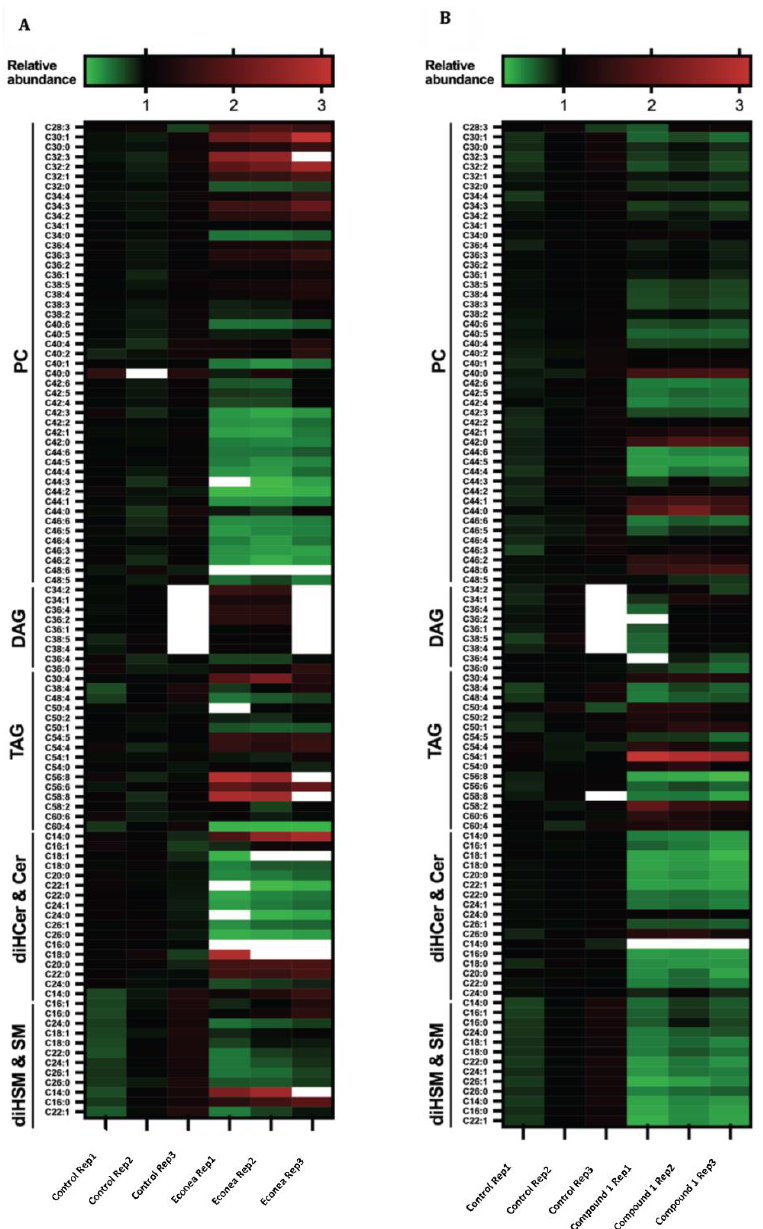
Figure 3. Heat map of differentially expressed lipids in several replicates of control, 10 µM of the Econea ® ( A ), and compound 1 ( B ) treated groups for a period of 24 h. White cells represent “not detected” lipids.